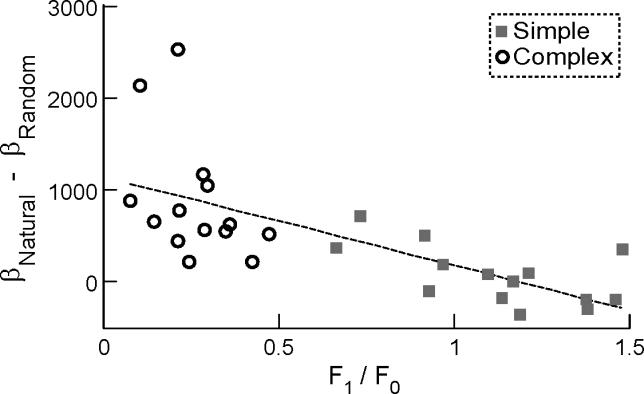
Difference in Feature Sensitivity between the Responses to Natural and Random Stimuli as a Function of F
1
/F
0
Each symbol represents data from one cell. For complex cells with two significant eigenvectors, the sensitivity difference was averaged between the two eigenvectors. Dashed line: linear fit.